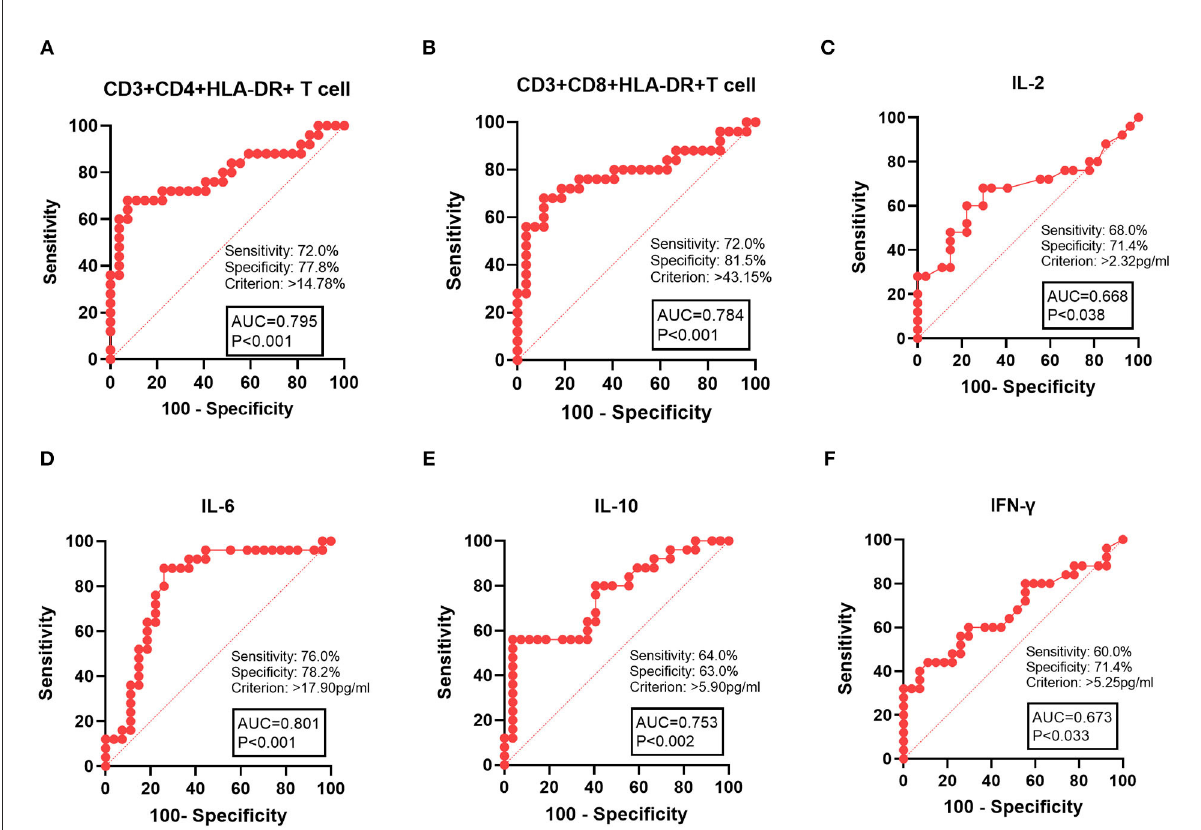
FIGURE3 ROC curve analysis of laboratory indices with patients with HL in the H-risk group. (A) CD3 + CD4 + HLA-DR + T cells, (B) CD3 + CD4 + HLA-DR + T cells, (C) IL-10, (D) IL-6, (E) , IL-10, and (F) IFN- γ . AUC, area under the ROC curve.